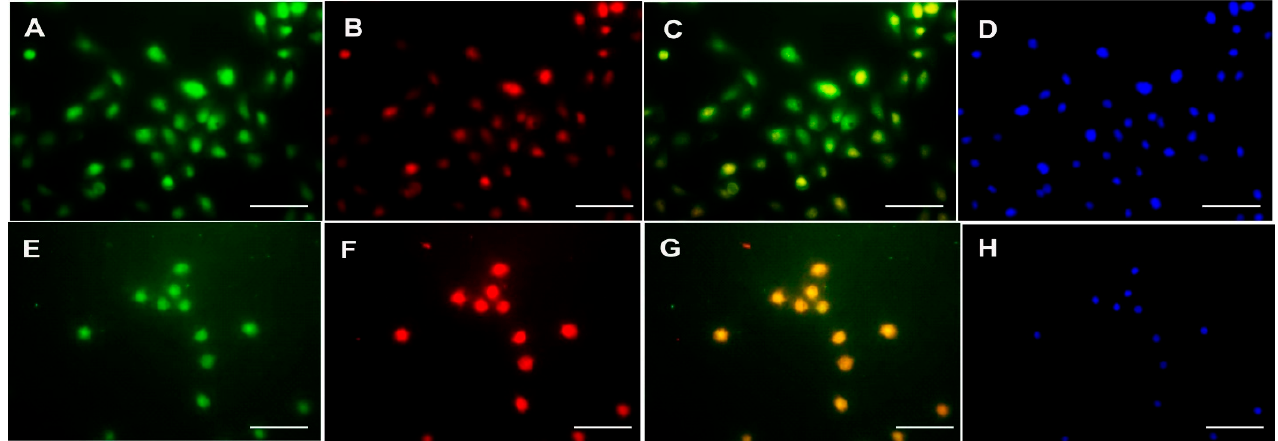
expression levels ( p > 0.05).